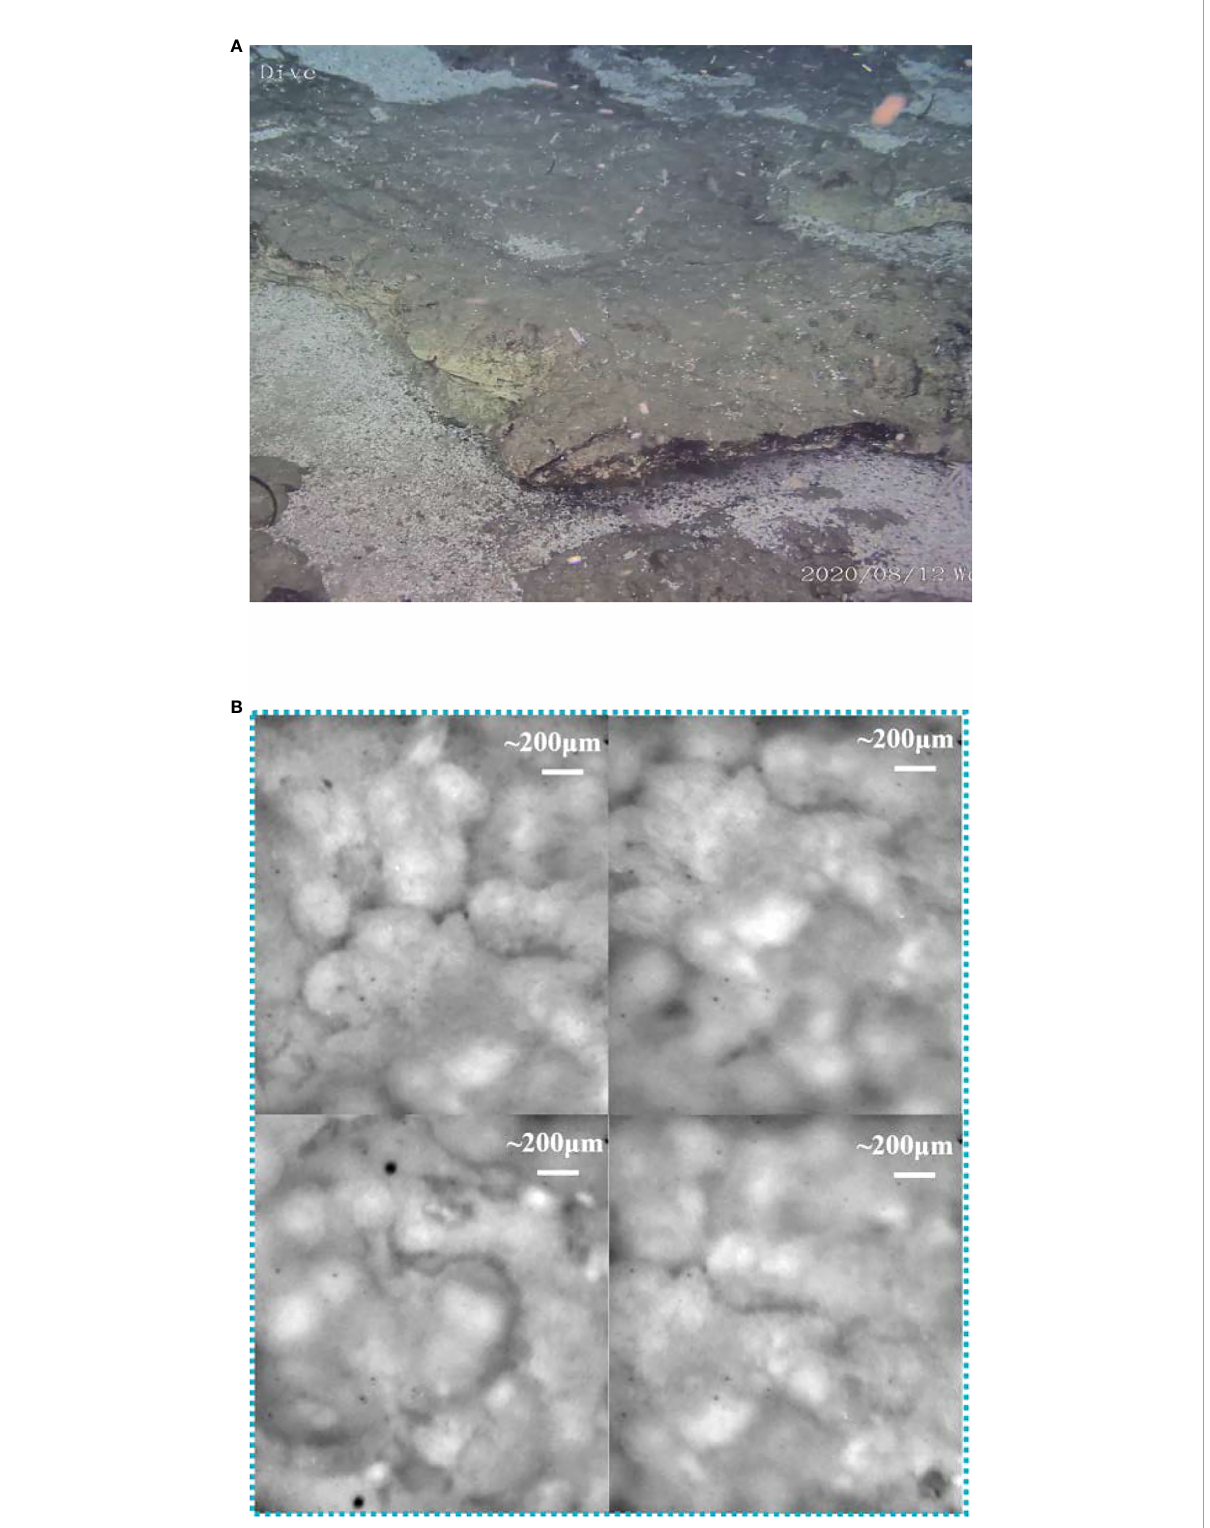
FIGURE 8 The macroimage of the seabed rock sample and its microimaging results. (A) The macroimages of the seabed obtained by ROV HD camera. (B) The microimaging results of the rock